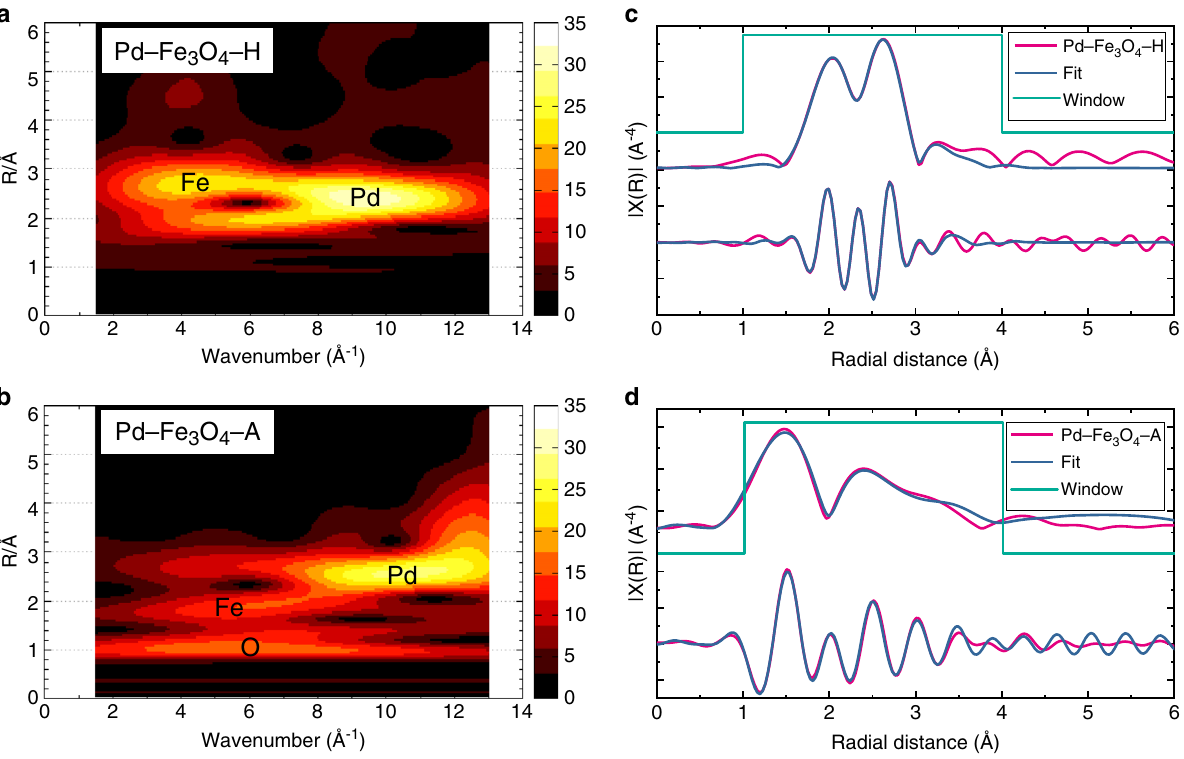
Fig. 4 Pd K-edge WT EXAFS and EXAFS fi tting using DFT-optimized results. a Pd K-edge WT EXAFS of Pd – Fe 3 O 4 – H; b WT EXAFS of Pd – Fe 3 O 4 – A; c EXAFS curve fi tting on DFT-optimized Pd – Fe 3 O 4 – H model; and d EXAFS curve fi tting on DFT-optimized Pd – Fe 3 O 4 – A model. Source data are provided as a Source data fi